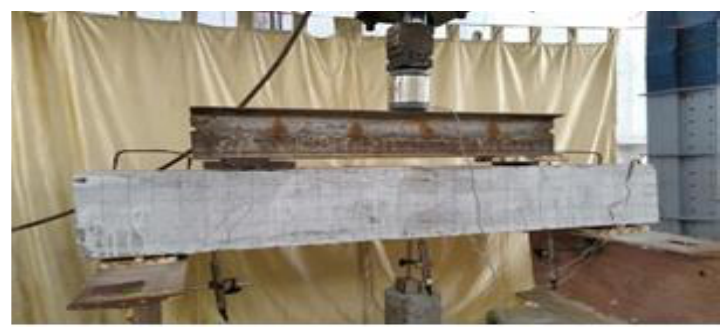
Figure 14. Crack pattern for Beam 1 (controlled concrete).